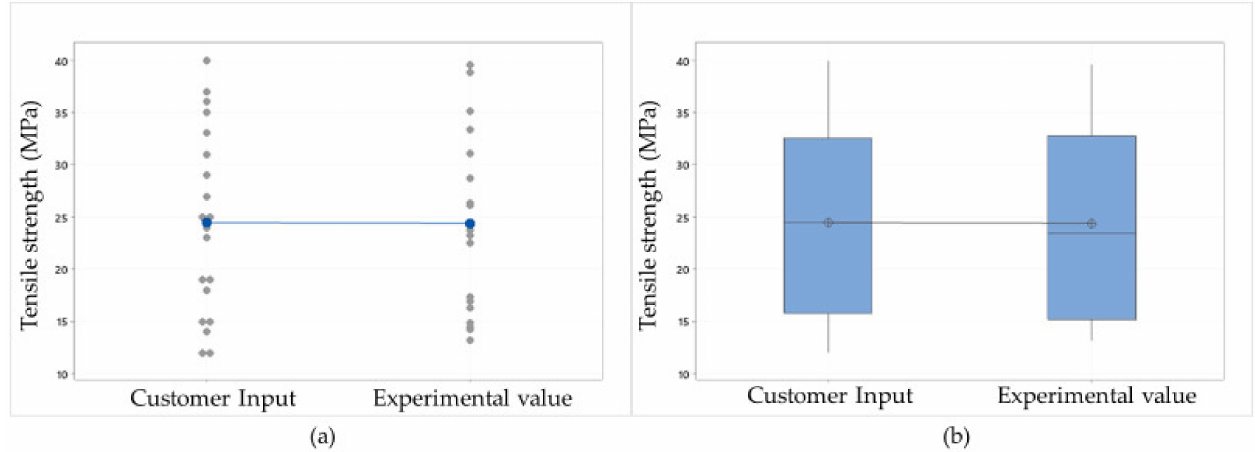
Figure 23. Graphical representation of t-tests: ( a ) individual value plot of customer input vs. experi- mental value; ( b ) boxplot of customer input and experimental